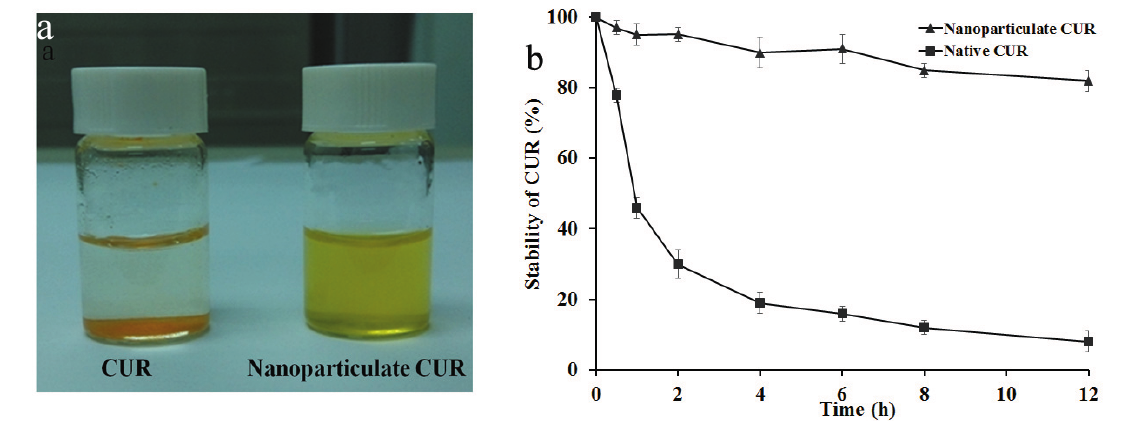
Figure 5. Solubility ( a ) and stability ( b ) of CUR and CUR NPs in phosphate buffered saline at 37 °C. Data are mean ± SD, n =